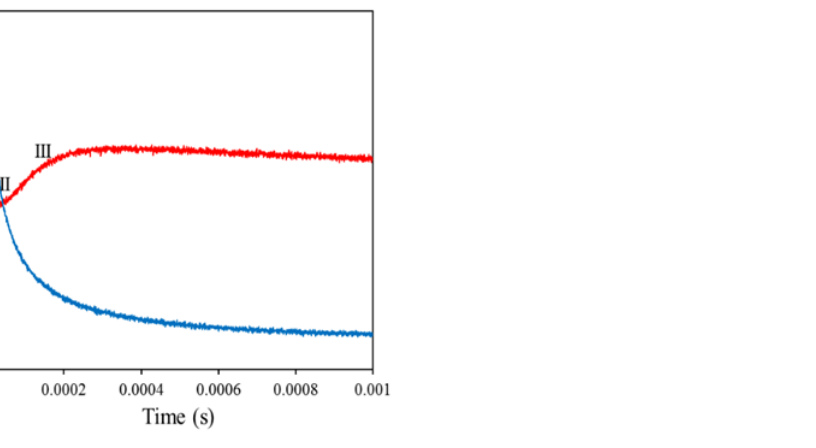
Figure 4. Red line, kinetics of the decay of radiation-generated morin N -Ac-Ala ● -NH 2 adduct. Blue line, bimolecular decay of Morin ● . Red line: Formation and decay of the adduct. The solution contained 15 mM N -Ac-Ala-NH 2 , 75 µM morin, and 20 mM phosphate pH 7.4; it was saturated with N 2 O and pulse-irradiated with a dose of ~30 Gy [73].